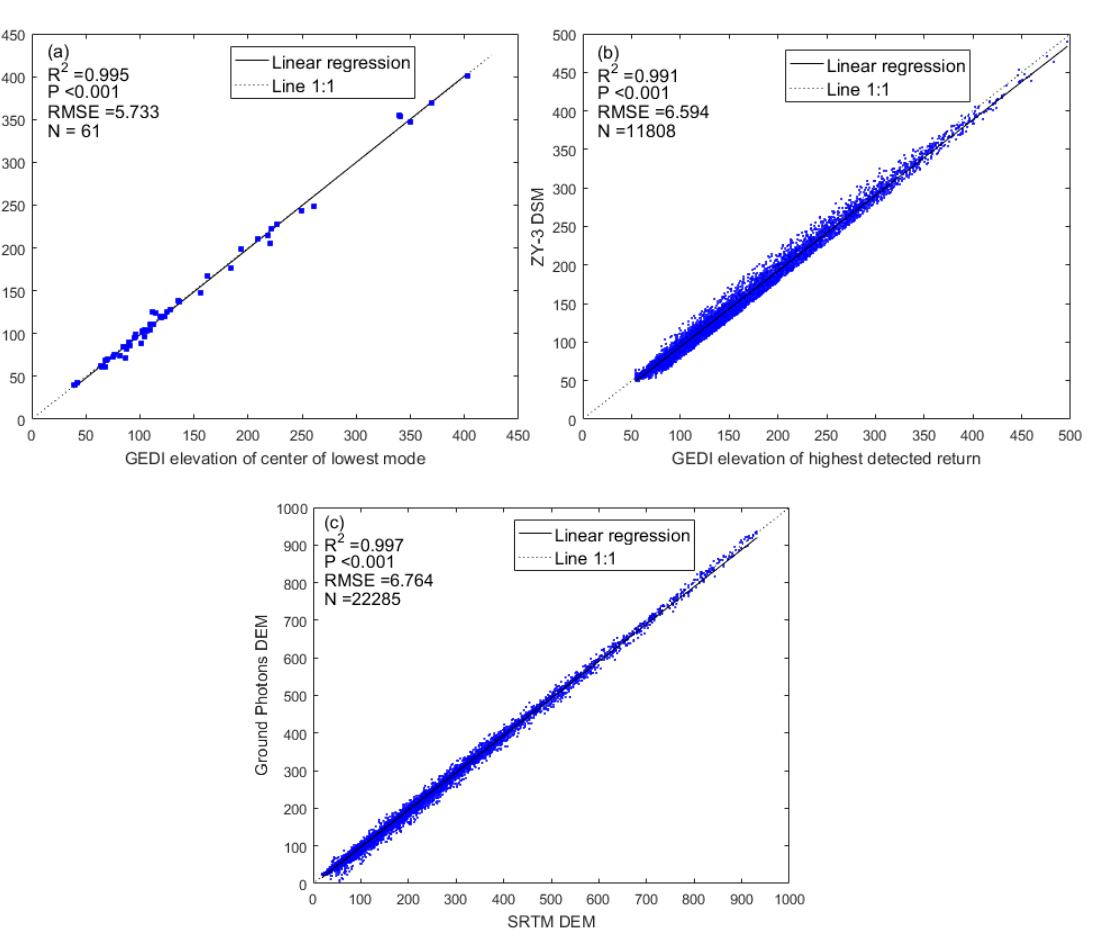
Figure 9. Comparison of DSM and ground photon average height values with GEDI data. ( a ) shows the relationship between GEDI terrain elevation and ground photon terrain elevation; ( b ) shows the relationship between GEDI land surface elevation and ZY-3 DSM; ( c ) shows the relationship between the SRTM DEM and ground photon terrain elevation.).